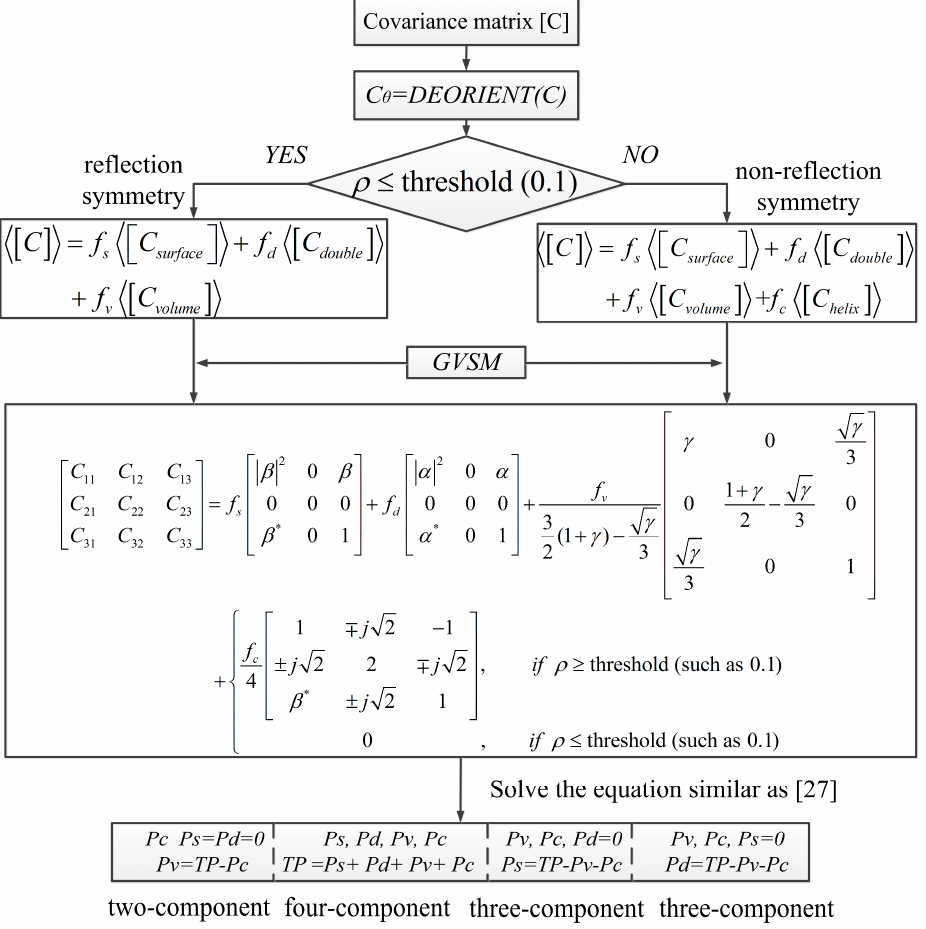
Figure 6 . The flow chart of the improved model-based decomposition integrating deorientation and GVSM.